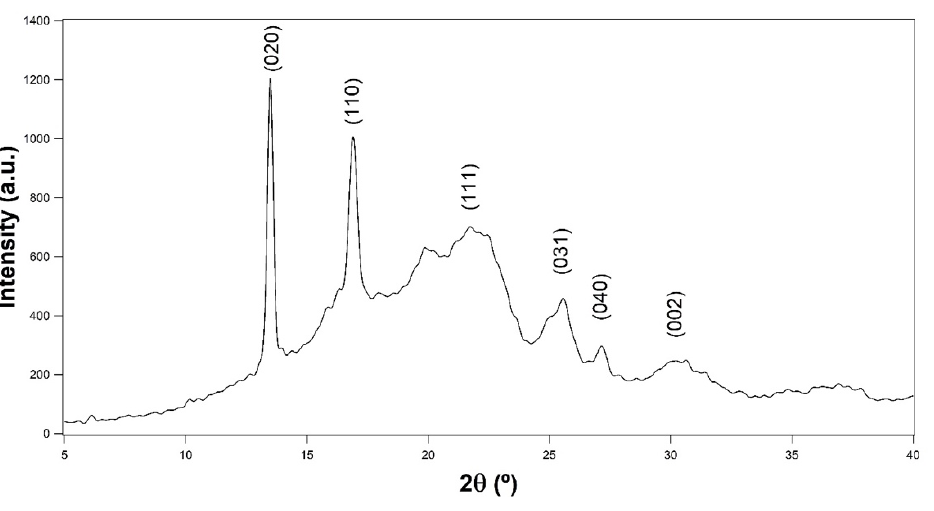
Figure 3. XRD pattern of P − 0. Table 4. Crystallinity parameters of the PHBH films.